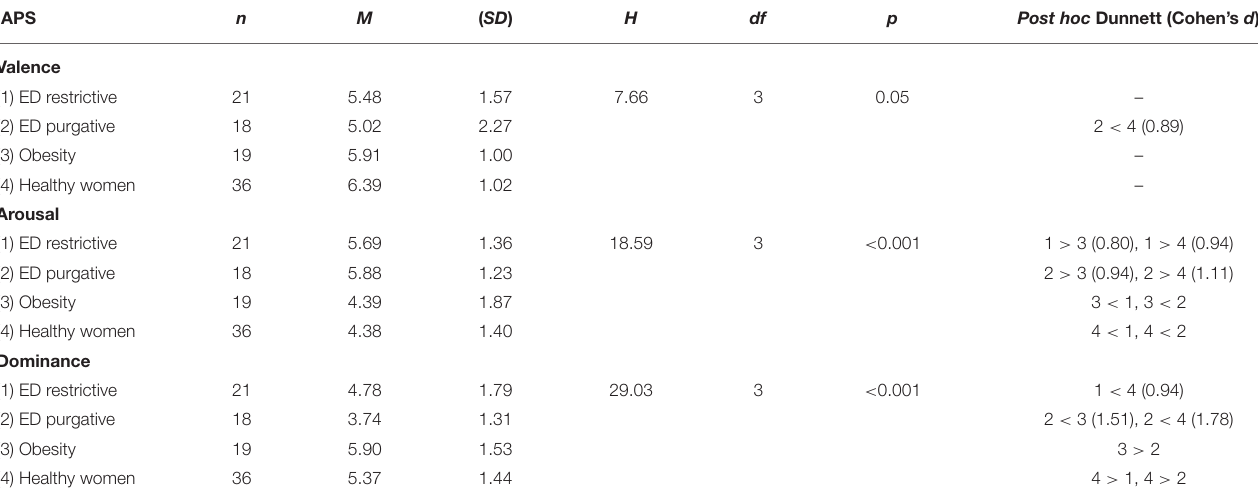
TABLE 1 | Kruskal–Wallis test between membership groups on emotional processing score. IAPS